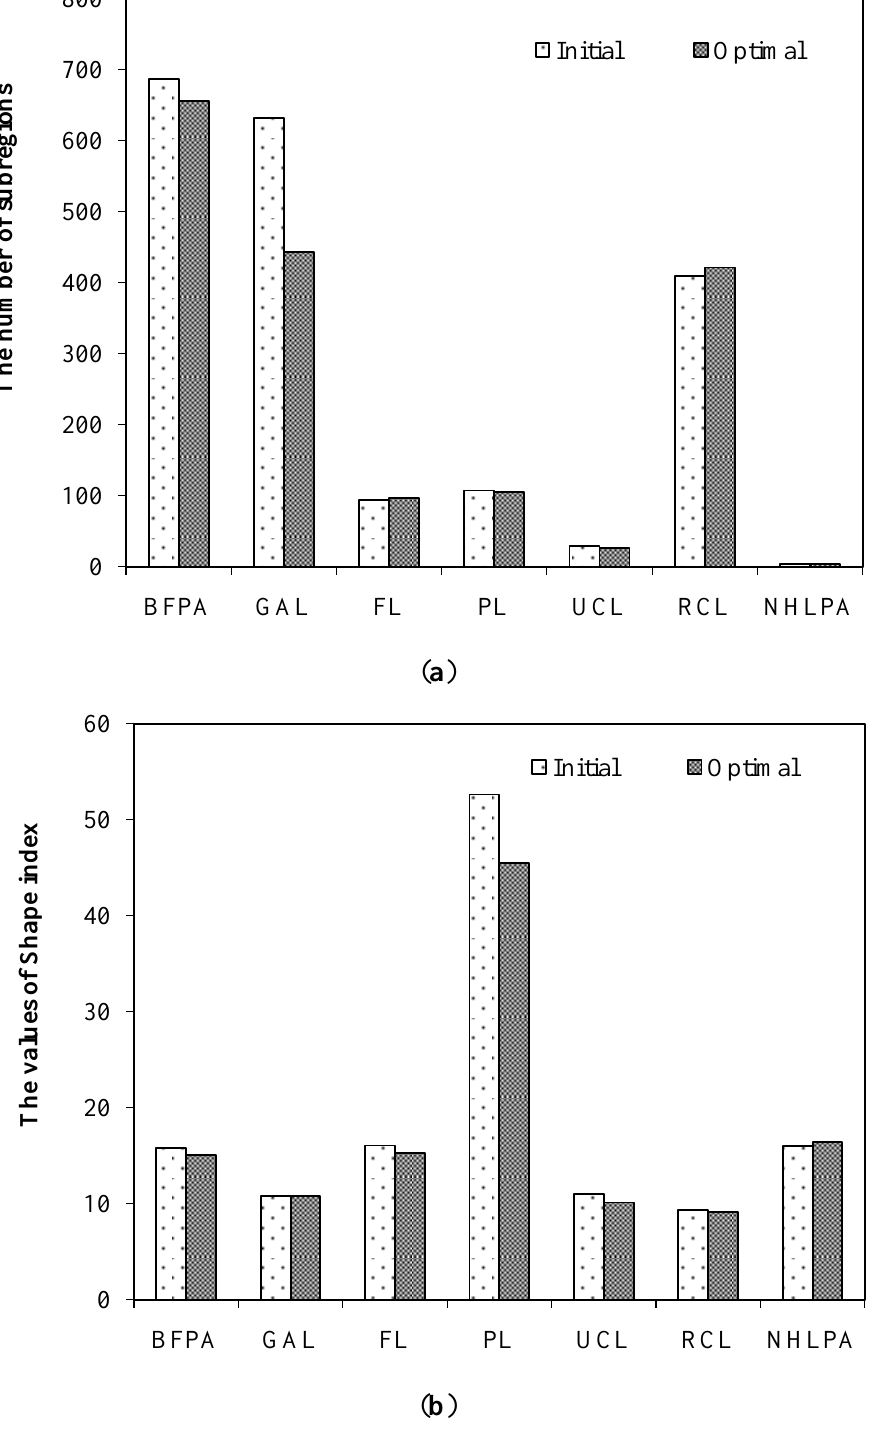
Figure 11. The comparison of spatial compactness between the initial and the optimal zoning solution: ( a ) spatial contiguity; ( b ) shape